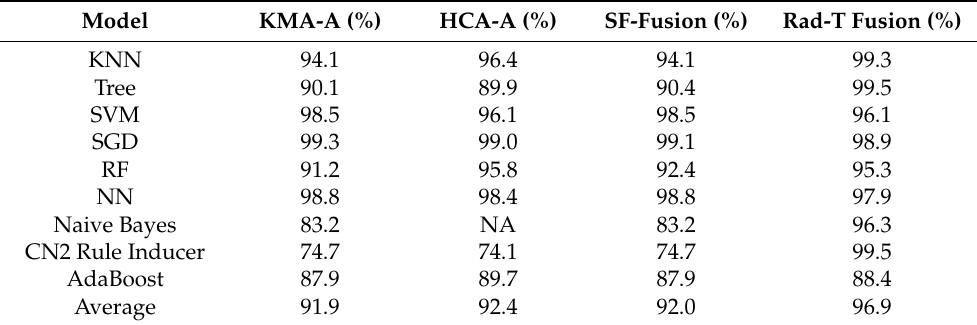
Table 6. Model averages from KMA (Table 2), HCA (Table 3), SF-Fusion (Table 4), and Rad-T (Table 5).